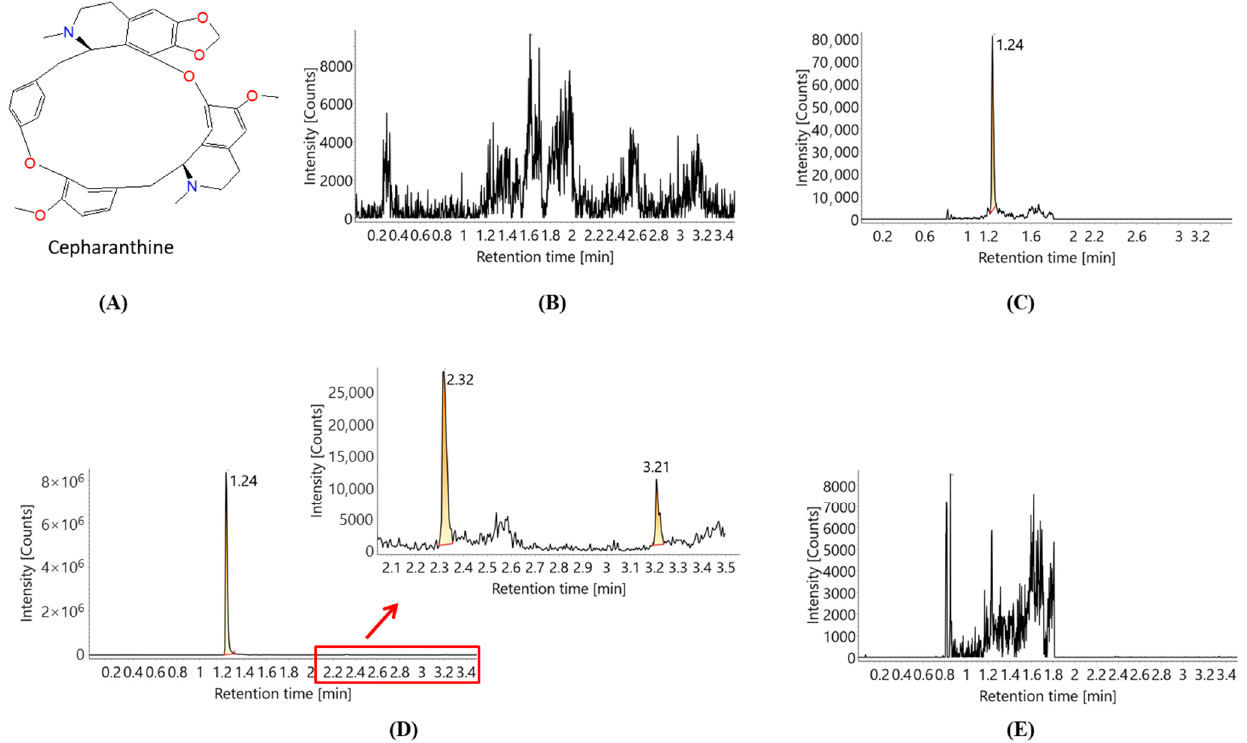
Figure 1. Chemical structure and MRM chromatograms of CEP in rat plasma samples: ( A ) chemical structure of CEP; ( B ) blank sample; ( C ) standard sample at the LLOQ (0.5 ng/mL); ( D ) top calibration standard (100 ng/mL) by multiple gradient elution; ( E ) blank sample after injection of the top calibration standard.